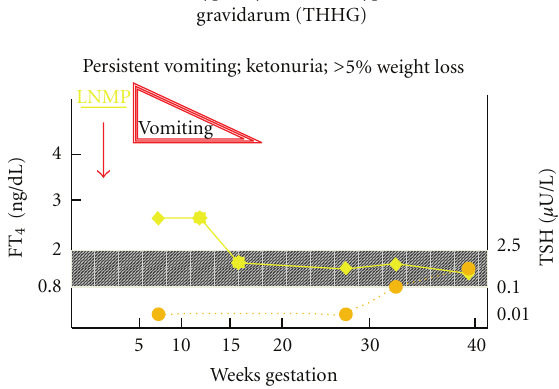
Figure 1: A representative example of transient hyperthyroidism of hyperemesis gravidarum. By week 6, vomiting begins and becomes severe by week 10. Serum-free thyroxine (T4) index is elevated and thyrotropin is suppressed. By weeks 16 to 18, vomiting subsides with marked improvement of the free T4 index value. During this period, the patient loses 3.6kg. By week 18, the serum free T4 index returns to normal, but the serum thyrotropin remains suppressed until week 26. Patient regains and gains weight with a term delivery of a healthy infant. The gray band indicates reference range. LNMP: last normal menstrual period. Patil-Sisodia and Mestman [12].